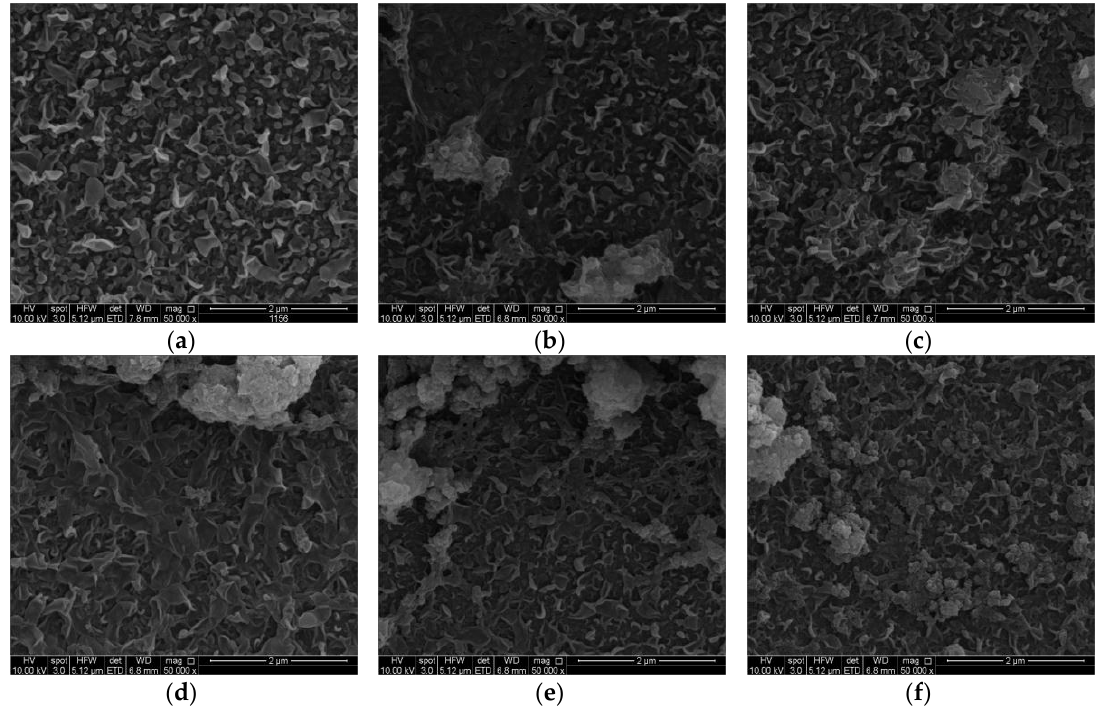
Figure 5. SEM images for membranes surface with MIL-125 NPs injection, ( a ) 0%, ( b ) 0.05%, ( c ) 0.1%, ( d ) 0.15%, ( e ) 0.2%, and ( f ) 0.3%.